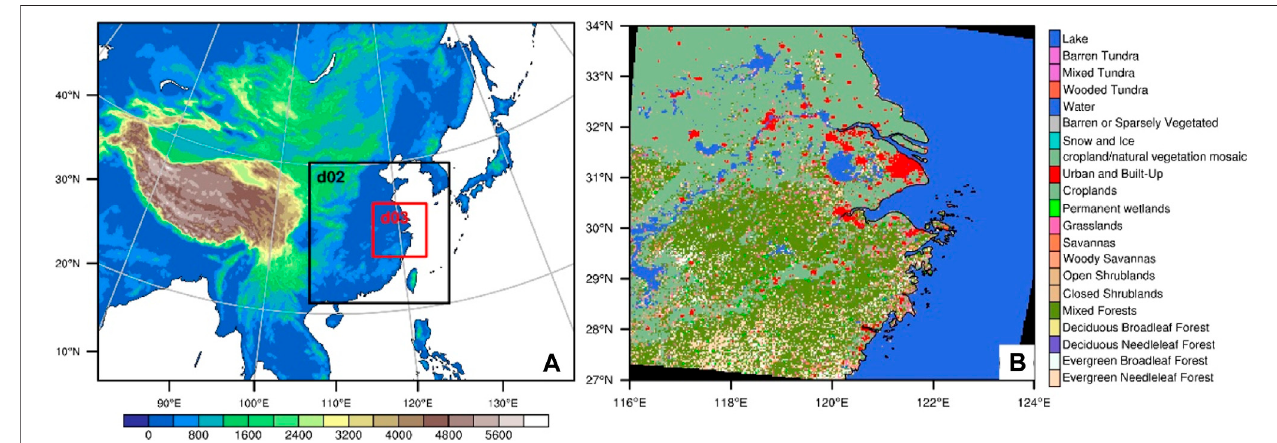
FIGURE 1 | (A) Model domain and terrain heights (units: m). The inner boxes represent the domains for the 3 km (d02) and 1 km (d03) resolution experiments, respectively. (B) The land cover map derived from MODIS covering the domain d03.